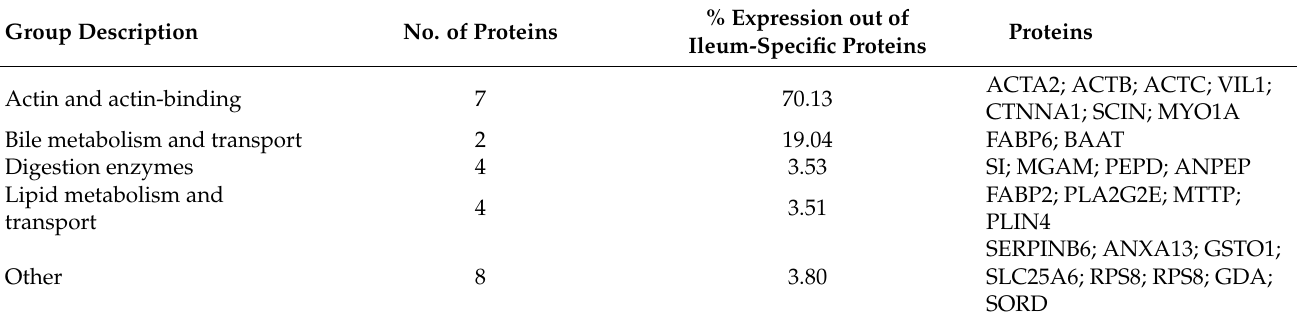
Table 2. Ileum-specific proteins grouped according to function.